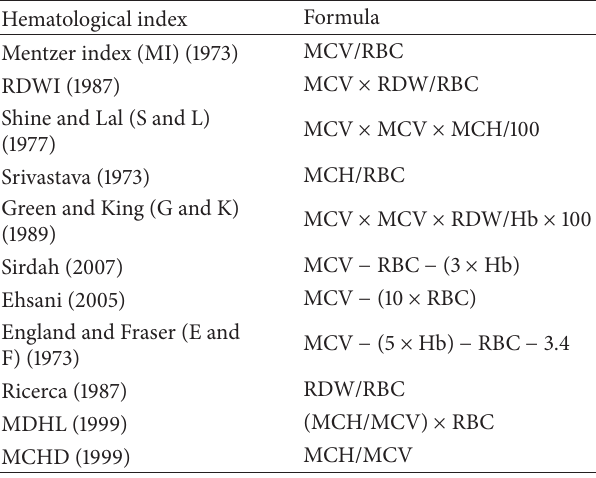
Table 2: Different RBC indices and mathematical formulas used to differentiate between 𝛽 -TT and